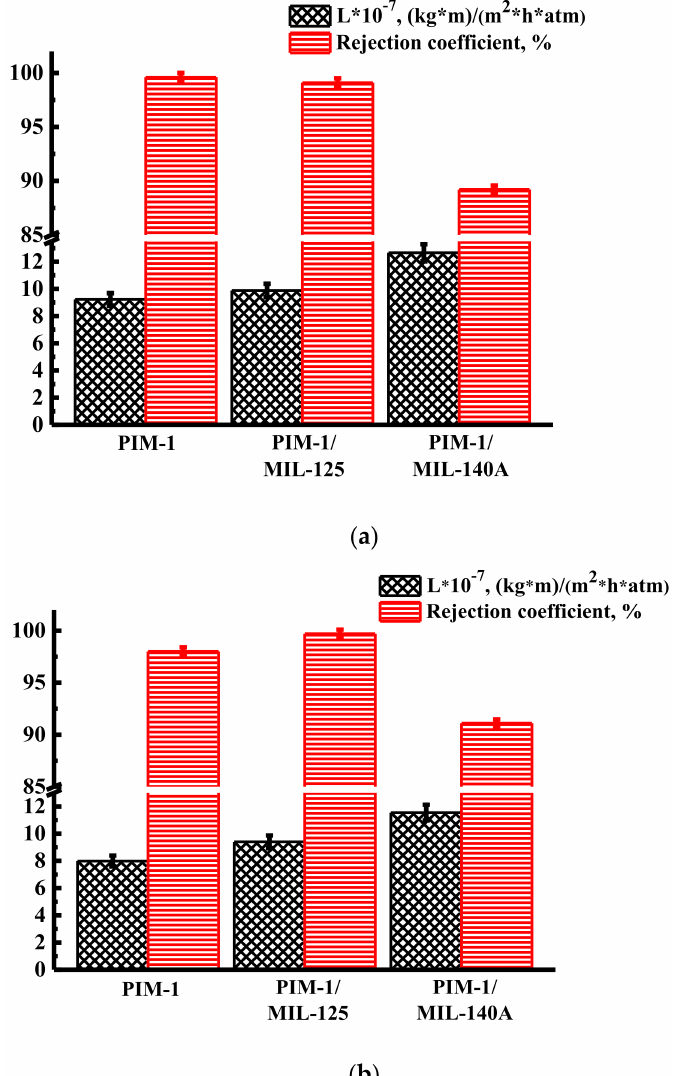
Figure 9. Transport properties of membranes (permeability and rejection coefficient) during nanofil- tration of ( a ) alfazurin (E133) and ( b ) yellow “sunset” (E129) dye solutions in ethanol at 40